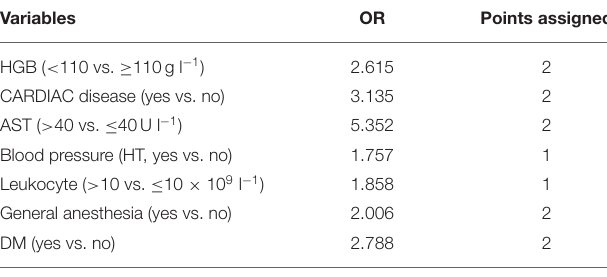
TABLE 5 | Score assignment of model variables.